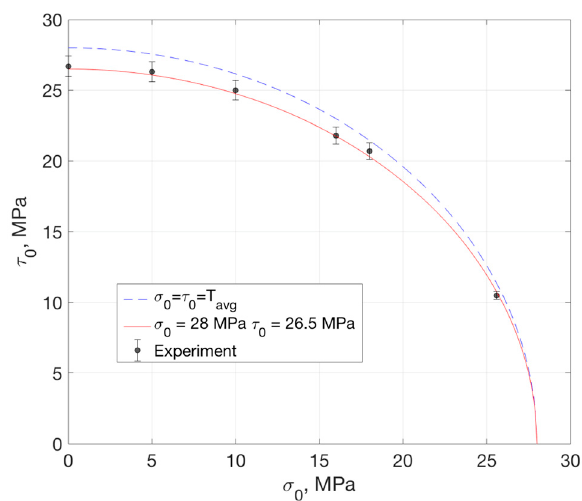
Figure 10. Failure criterion and experimental data.